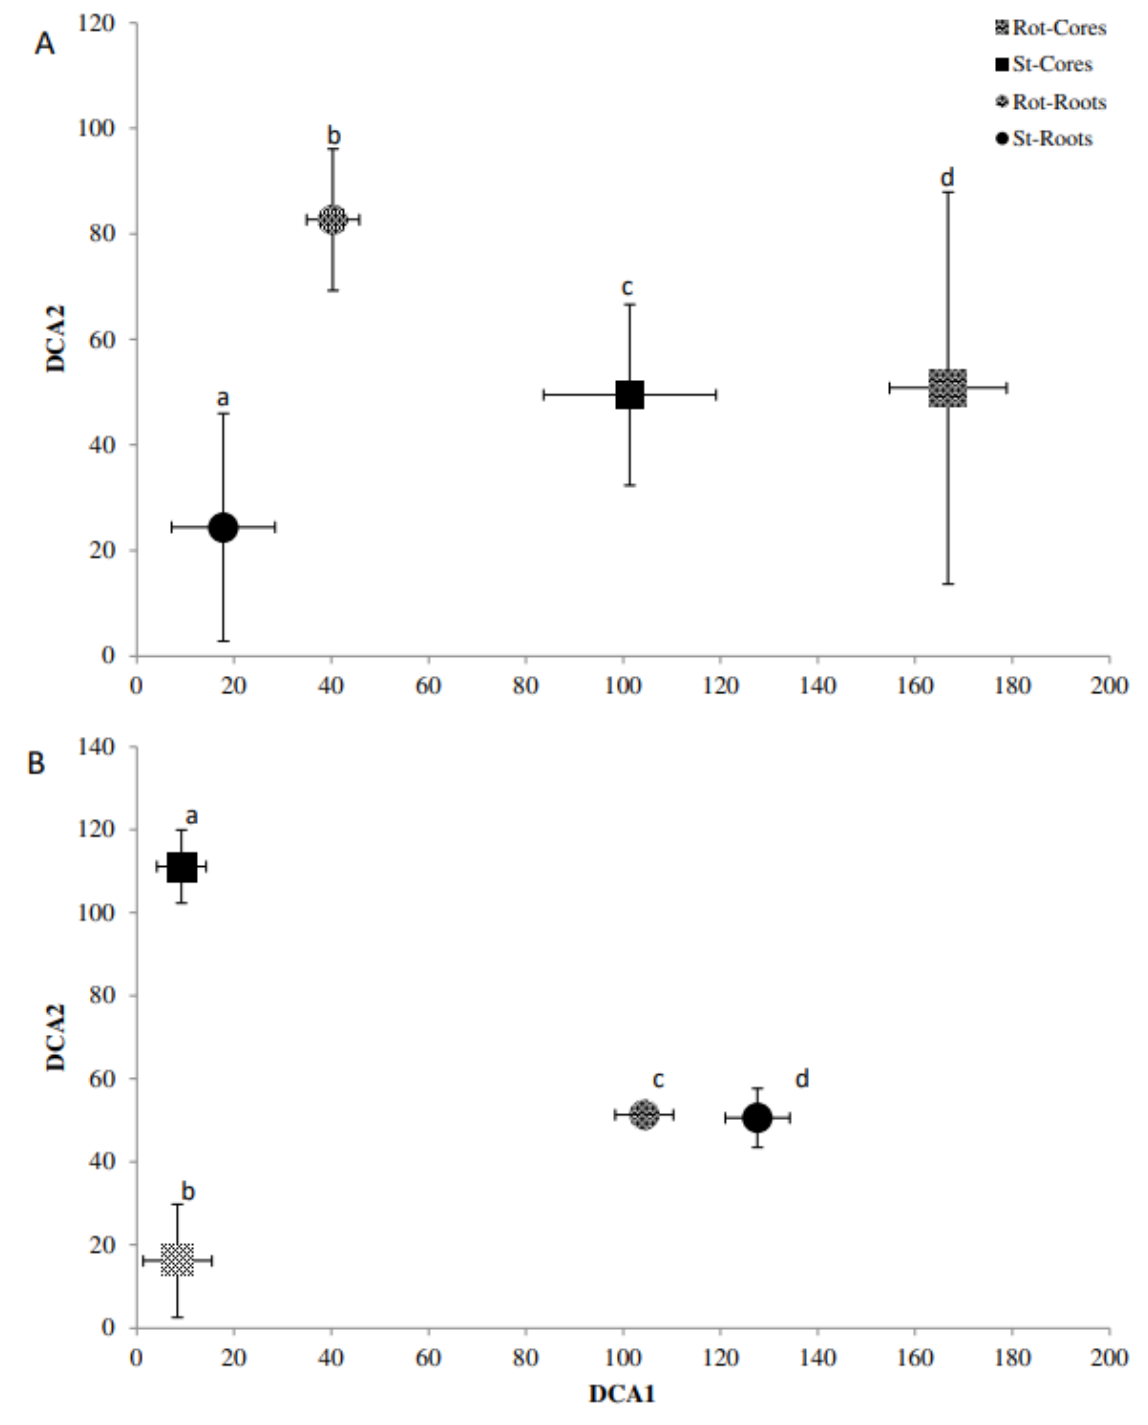
Figure 2. Detrended correspondence analysis (DCA) bi-plot of the 16S rRNA community fingerprint for Agrostis stolonifera ( A ) and Plantago lanceolata ( B ). DCA1 = Axis 1, DCA2 = Axis 2. Treatments; roots = circle, cores = square, static (St) = solid, rotating (Rot) = pattern. Letters (a–d) indicate significant differences; error bars represent standard deviation among replicates.